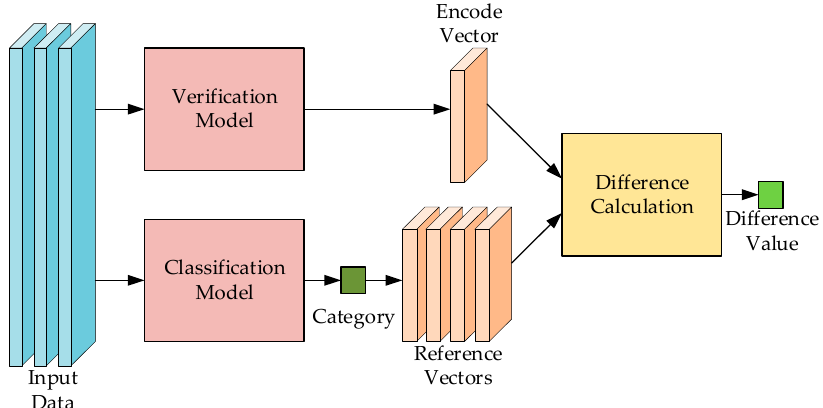
Figure 9. Data flow chart of the recognition–verification mechanism. The input of this mechanism is the sign language data pulled by the sliding window, and the output is the recognition category and the difference. The classification model, verification model, and difference calculation in the figure constitute the main body of the mechanism.